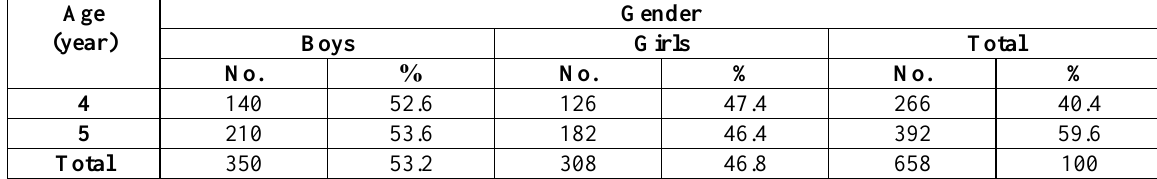
Table 1: The distribution of total sample by age and gender.